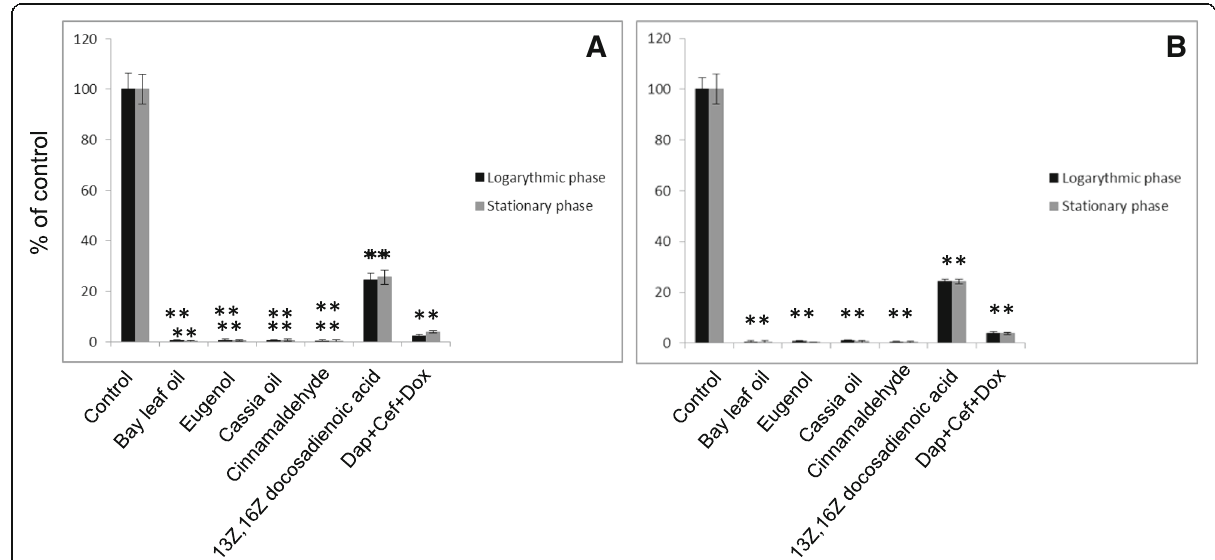
Fig. 2 Estimation of repopulated spirochete forms of Borrelia spp. Borrelia burgdorferi s.s. ( a ) and Borrelia garinii ( b ) were treated with test lipid (oils at 0.15% including their active ingredients at 0.125% concentration, 13Z,16Z docosadienoic acid at concentration 0.5 mg/ml) for 72 h and transferred to fresh tubes containing BSK-H medium only. After 14 days of sub-culturing, the presence of typical motile spirochetes were determined by SYBR Green I/PI assay using direct counting and fluorescence microscope; Dap+Cef + Dox – daptomycin+cefoperazone +doxycycline (as a positive control); * p ≤ 0.001 compared to